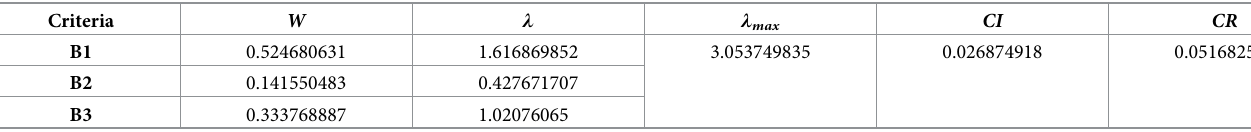
Table 10. Quantitative results of the AHP for the assessment of water resources.